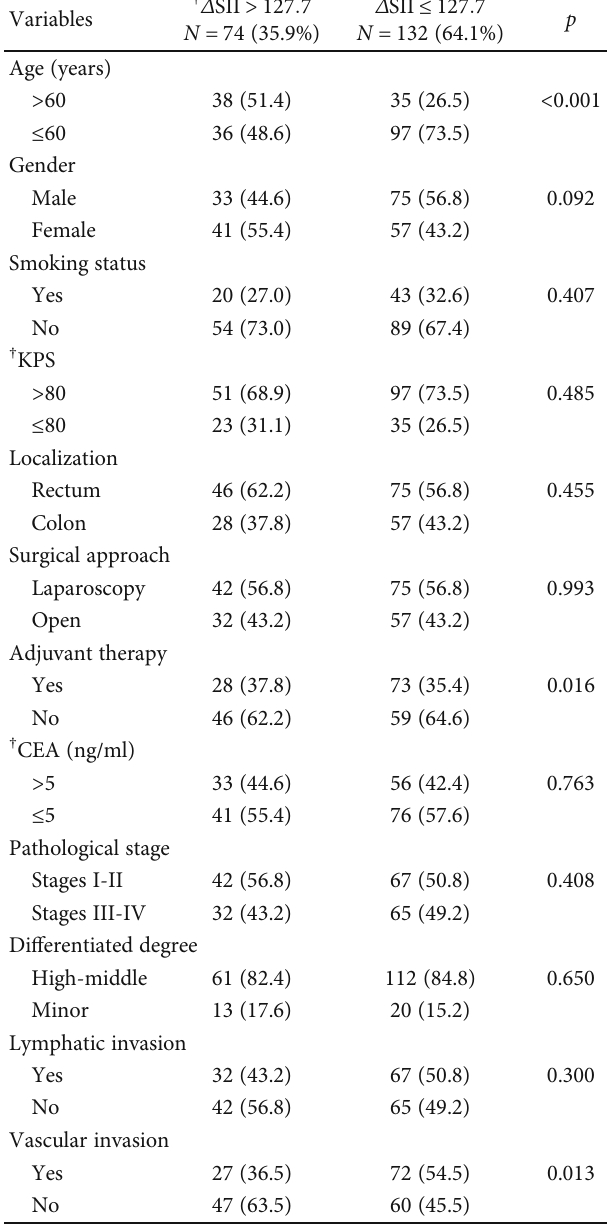
Table 2: Clinicopathological variables of 206 colorectal cancer patients according to the Δ